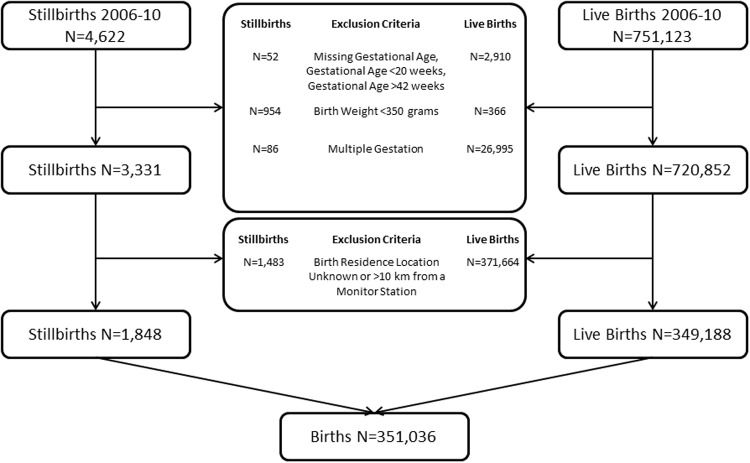
Flow diagram of the study population, Ohio births 2006–2010.